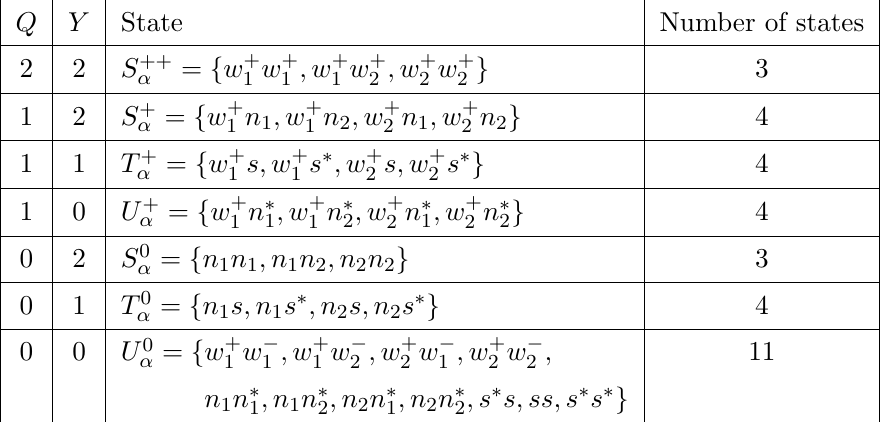
Table 1 . List of two body scalar states separated by ( Q; Y